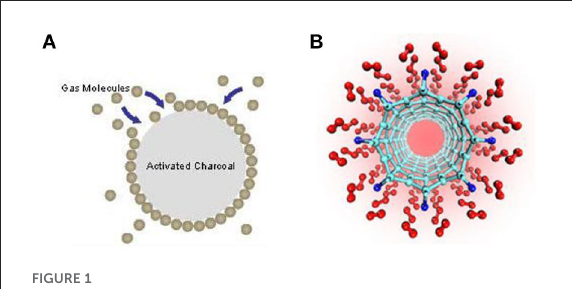
FIGURE1 (A,B) An example of physical sorption on the surface of a solid sorbent in a single-molecule layer (48).